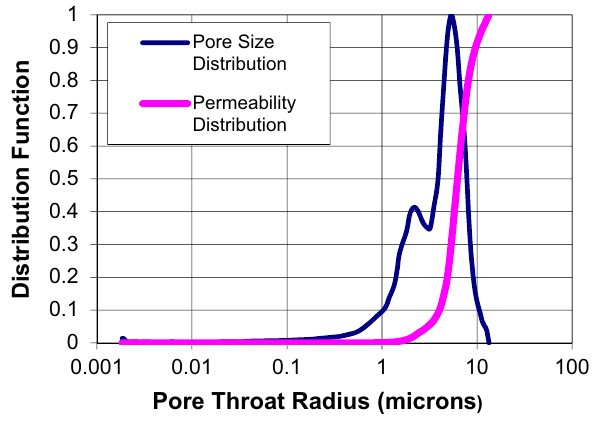
Fig. 5 Pore size and permeability distribution of a frame-stone sam- ple from sample depth of 2086.30 m